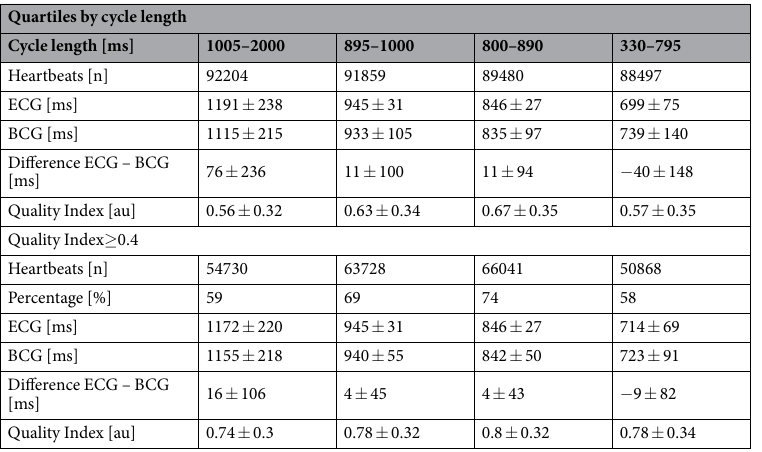
Table 3. All analysed heartbeats were classified by cycle length in 4 similar sized groups. Second and third quartile group show best accordance in mean absolute difference between BCG and ECG and the resulting QI. The group with low or high heart rate show a poorer agreement. By filtering heartbeats with lower signal quality, the accordance could be improved especially in the quartiles with low and high cycle length compared to the two middle quartiles with normal cycle length.